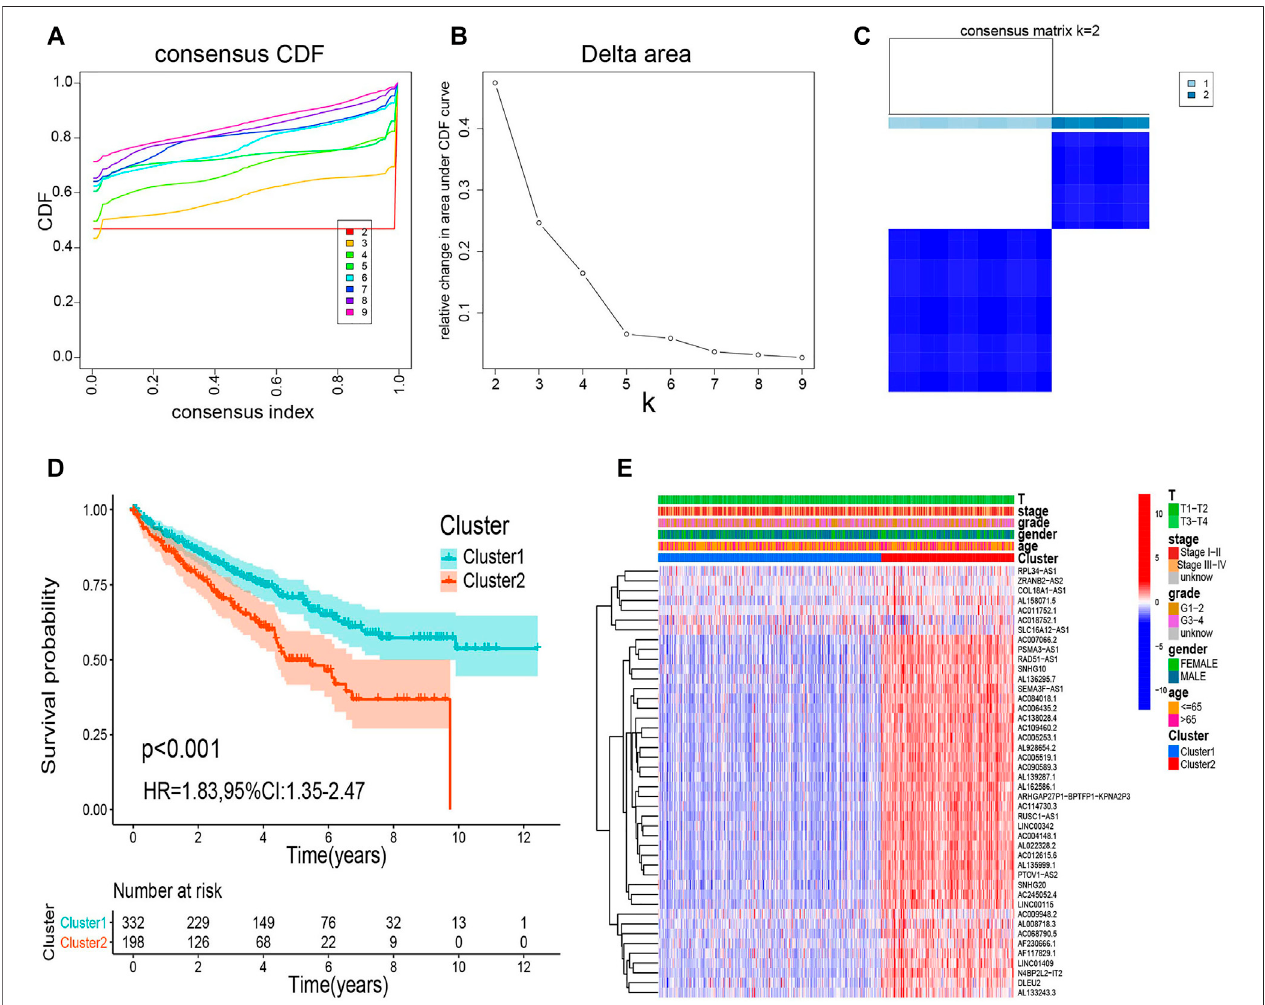
FIGURE2| Consensusclusteringanalysisofm6A-RLexpression. (A) Consensusclusteringcumulativedistributionfunctionfork (cid:1) 2to9. (B) Relativechangeinthe area under the cumulative distribution function curve for k (cid:1) 2 to 9. (C) Consensus matrix for k (cid:1) 2. (D) Kaplan – Meier survival analysis of the overall survival (OS) for the two clusters. (E) Relationships between m6A-RL expression and clinicopathological